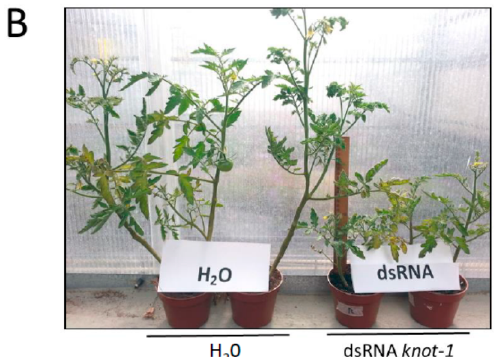
Figure 7. TYLCV amounts and symptoms in tomato plants infected by viruliferous whiteflies without (H 2 O) and with knot-1 silenced gene. ( A ) Viral amounts (viral genomes per plant β -actin gene) in tomato plants 19 days after infection by viruliferous whiteflies without (H 2 O) and with knot-1 silenced (dsRNA knot-1 ); ( B ) symptom appearance of tomato plants 24 days after infection with not-silenced (H 2 O) and knot-1 silenced insects (dsRNA knot-1 ).